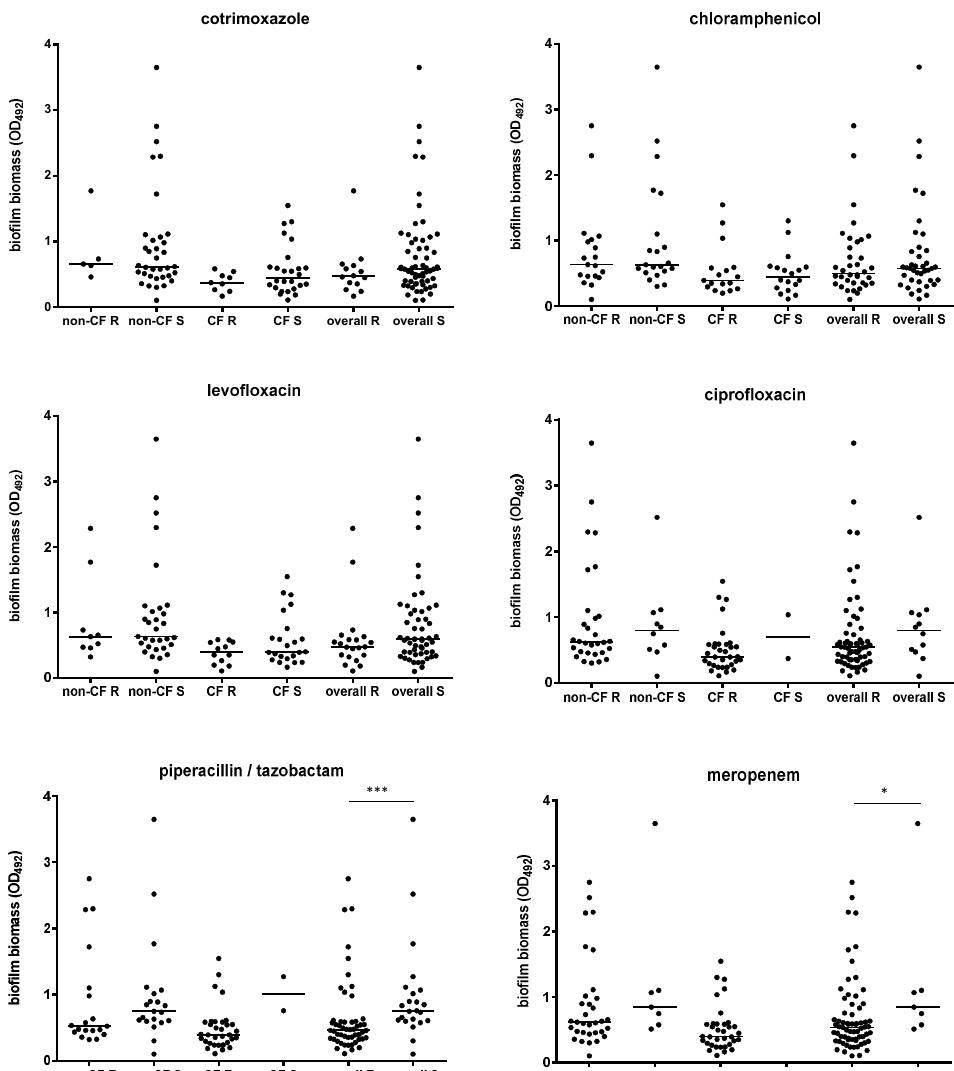
Figure 4. Biofilm formation according to antibiotic resistance and patient type. Biofilm biomass formation, spectrophotometrically assessed by crystal violet assay, was stratified on each antibiotic tested—according to susceptibility (S) or resistance (R)—and patient type. Results are shown as scatter plots, with horizontal lines indicating the median values. Significance level at Mann–Whitney test: * p < 0.05; *** p < 0.0001.